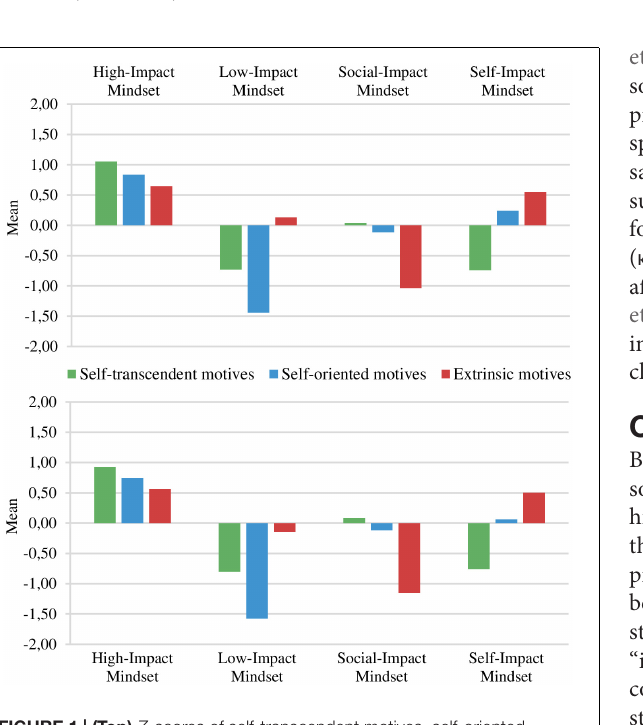
FIGURE 1 | (Top) Z -scores of self-transcendent motives, self-oriented motives, and extrinsic motives of the four-cluster solution, Sample 1 ( n = 763). (Bottom) Z -scores of self-transcendent motives, self-oriented motives, and extrinsic motives of the four-cluster solution, Sample 2 ( n =